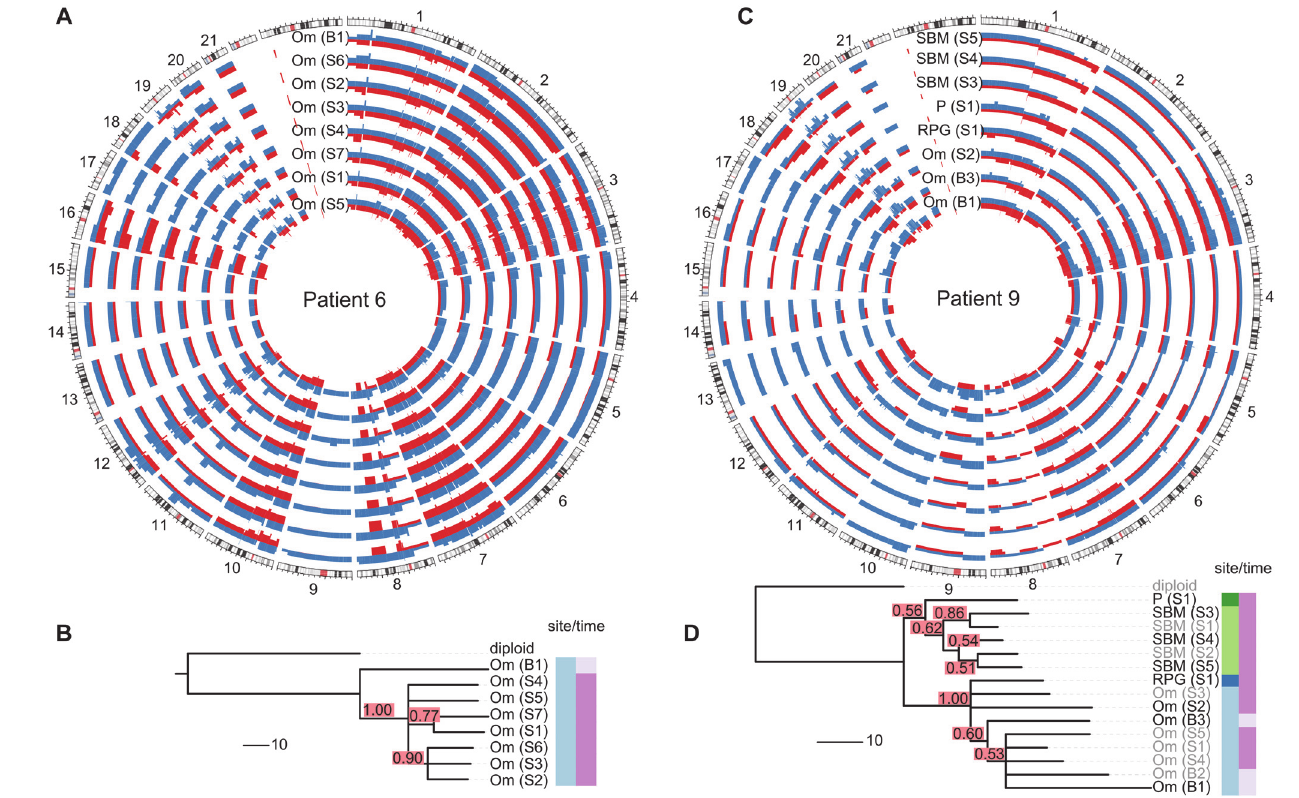
Fig 2. Examples of spatial and temporal heterogeneity in HGSOC. (A and C) Total copy number profiles show strong overall conservation. As examples, a representative subset of the allele-specific genomic copy number profiles of patients 6 and 9 are shown. Separate alleles are indicated in red and blue. (B and D) Genomic changes between biopsy and surgery reveal tumour evolution. The black sample names in the trees indicate the samples shown in the Circos plots. Confidence values for each split are printed in red boxes. The colour-coded bars on the right of the phylogenies indicate different sites (left column) and different sampling times (right column). Branch lengths indicate number of genetic events as determined by MEDICC (scale bar shows ten events). Om, omentum; P, peritoneum; RPG, right paracolic gutter; SBM, small bowel mesentery.